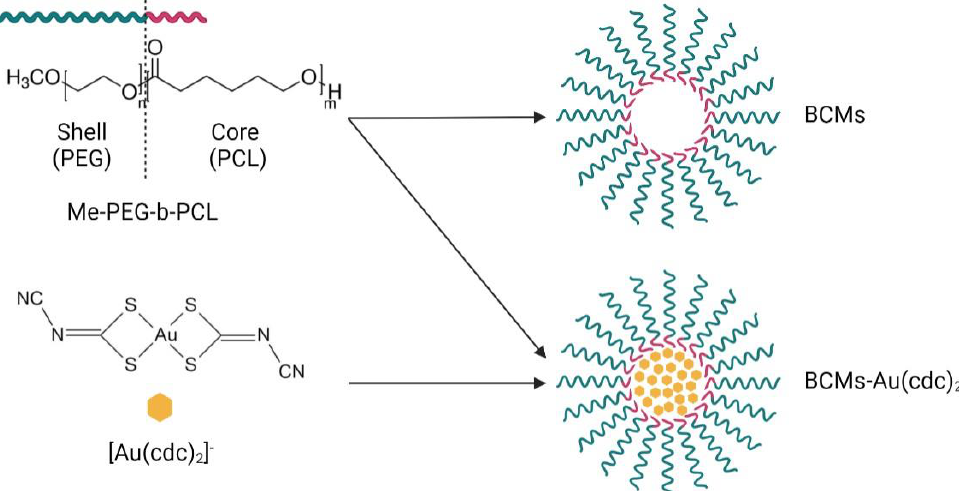
Figure 2. Synthesis of the micelles. BCMs correspond to the non-loaded micelles and BCMs- [Au(cdc) 2 ] correspond to the loaded micelles.